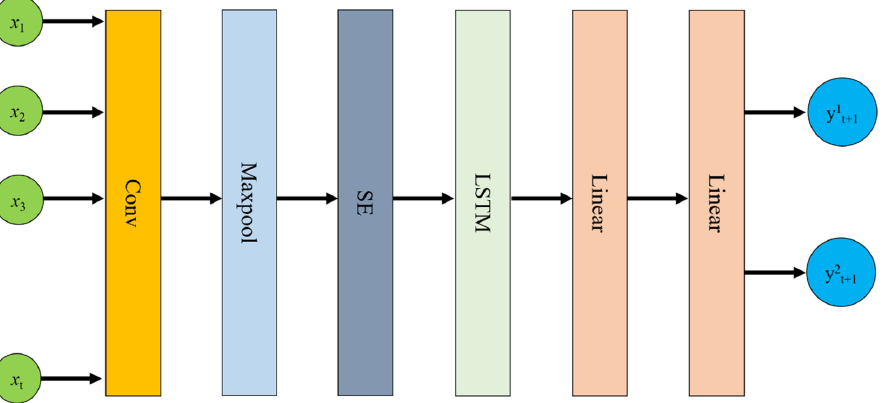
Figure 4. The overall structure of the prediction model.